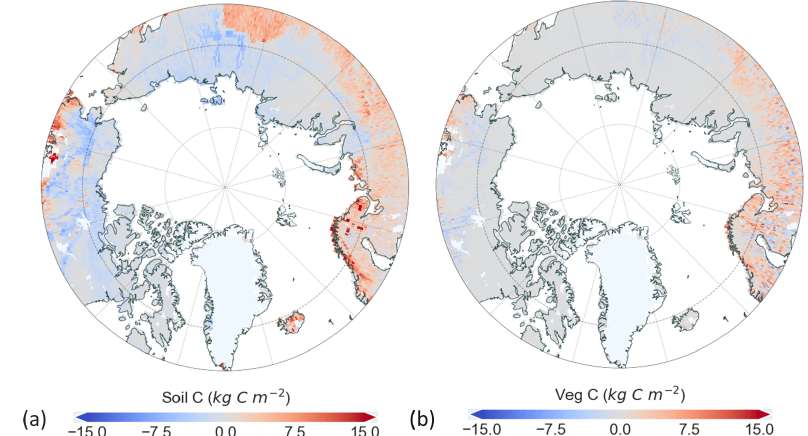
Figure 9. The difference in simulated soil (a) and vegetation carbon pools (b) between the two schemes. Differences are calculated by subtracting the Static from Dynamic simulation